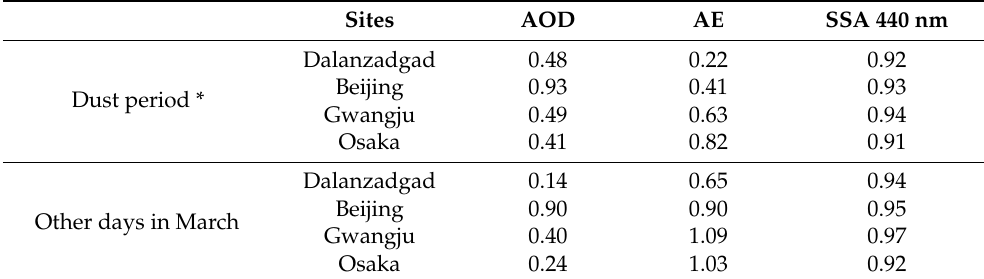
* “Dust period” represents the period during two dust events from 14 to 18 March 2021 and 26 to 30 March